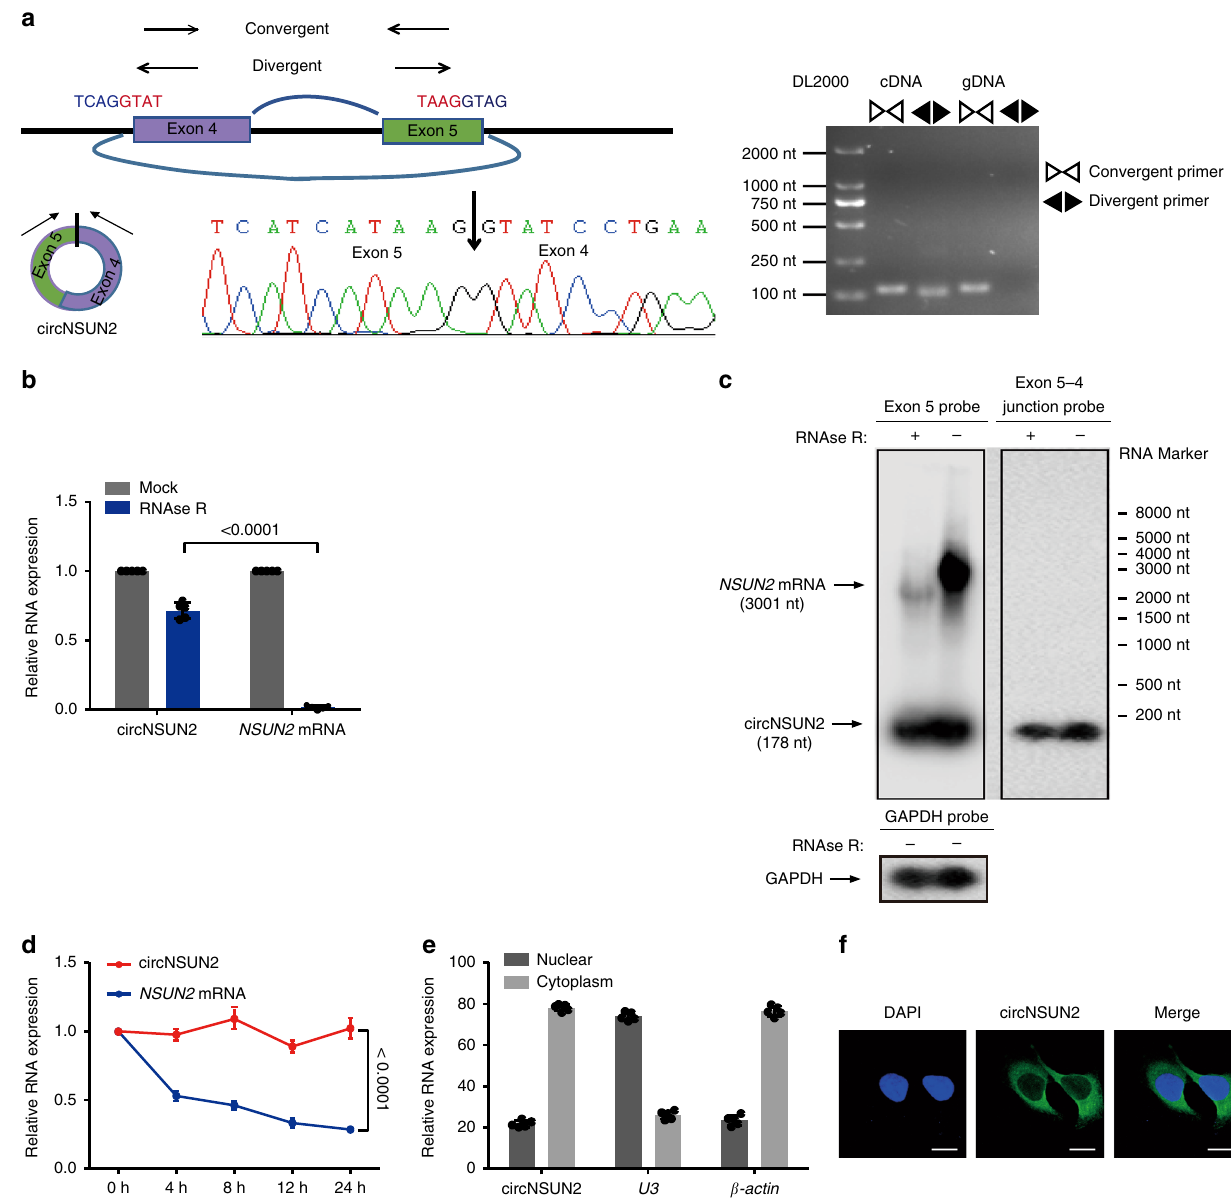
Fig. 2 Characterization of circNSUN2 in CRC. a The genomic locus of circNSUN2. Left, the expression of circNSUN2 was detected by qRT-PCR followed by Sanger sequencing. Arrows represent divergent primers binding to the genome region of circNSUN2. Right, qRT-PCR products with divergent primers showing circularization of circNSUN2. cDNA complementary DNA. gDNA genomic DNA. b qRT – PCR analysis for the expression of circNSUN2 and NSUN2 mRNA after treatment with RNase R in HCT116 cells. Data represent mean ± S.D. from fi ve independent experiments; dot plot re fl ects data points from independent experiment. The P value was determined by a two-tailed unpaired Student ’ s t test. c Northern blotting of circNSUN2 and NSUN2 transcripts by hybridization with exon5 (top, left) and exon 5 − exon 4 junction (top, right) probes in the presence or absence of RNase R treatment. Right, RNA marker. GAPDH mRNA (bottom) was also blotted as an internal control. The samples for blotting GAPDH were aliquoted before RNase R treatment and loaded separately in two wells for validation. d qRT – PCR analysis for the expression of circNSUN2 and NSUN2 mRNAs after treatment with Actinomycin D at the indicated time points in HCT116 cells. Data represent mean ± S.D. from fi ve independent experiments; dot plot re fl ects data points from independent experiment. The P value was determined by a two-way ANOVA. e Cytoplasmic and Nuclear mRNA Fractionation experiment showing that circNSUN2 localized in the nucleus and the cytoplasm. β -actin and U3 were applied as positive controls in the cytoplasm and nucleus, respectively. Data represent mean ± S.D. from fi ve independent experiments; dot plot re fl ects data points from independent experiment. f RNA fl uorescence in situ hybridization for circNSUN2. Nuclei were stained with DAPI. Scale bar, 10 µ m. For c and f , junction probe is complementary to the junction sequence of circNSUN2. Source data are provided as a Source Data fi showed that the half-life of circNSUN2 exceeded 24 h, whereas exon 5 − exon 4 junction to distinguish circNSUN2, and probes that of the associated linear transcript exhibited about 4 h that hybridize with exon 5 to distinguish circNSUN2 and its host (Fig. 2d), indicating that circNSUN2 is more stable in CRC cells. gene, NSUN2 , by northern blotting (Fig. 2c). After treatment with Further nuclear and cytoplasmic fractionation (Fig. 2e) and Actinomycin D, an inhibitor of transcription, qRT-PCR analysis